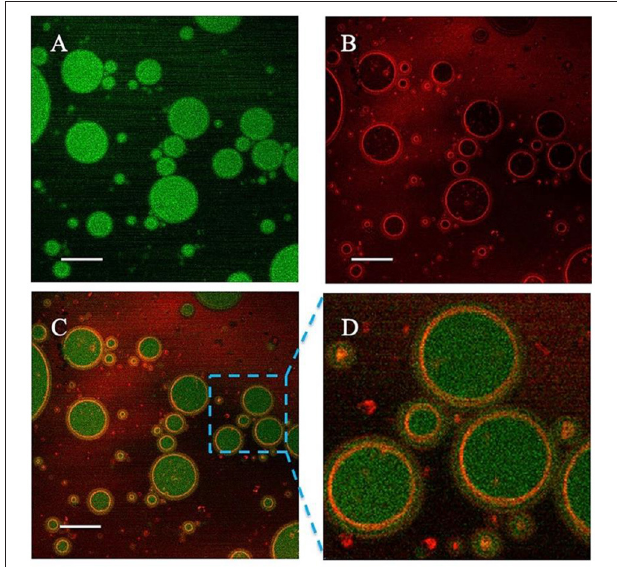
FIGURE 4 | Confocal laser scanning microscope (CLSM) images of the proteins-stabilized emulsions. (A) Nile red fluorescence (green) labeling Sunflower seed oil excited; (B) Nile Blue fluorescence (red) labeling proteins; (C) The overlapped image; (D) Enlarged image. Scale bar = 5 µ m.